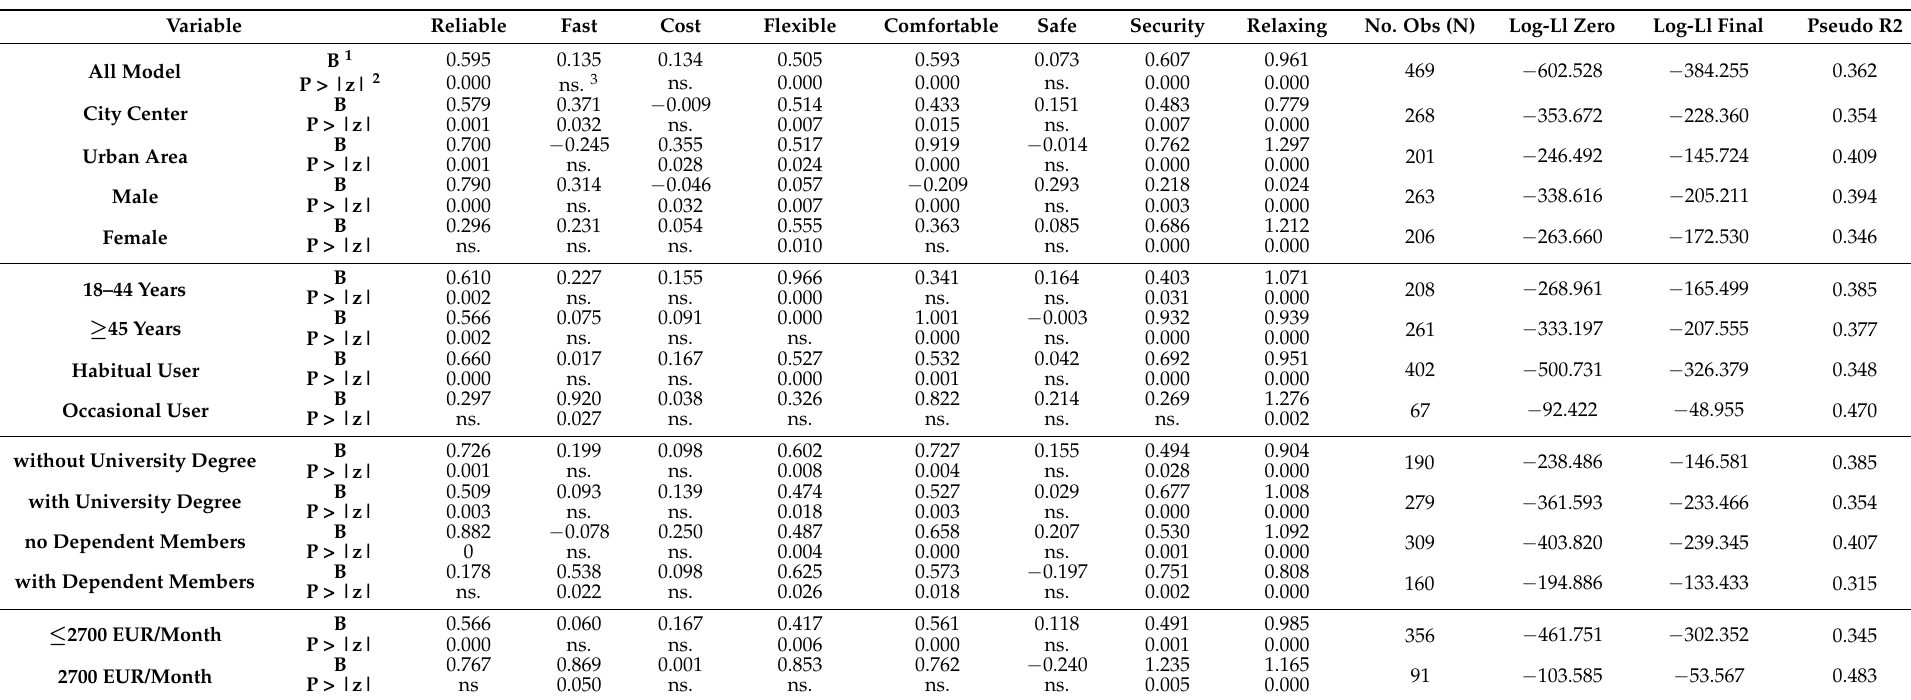
Table 1. The results of ordered logit models for several segments of socio-demographic and travel characteristics.